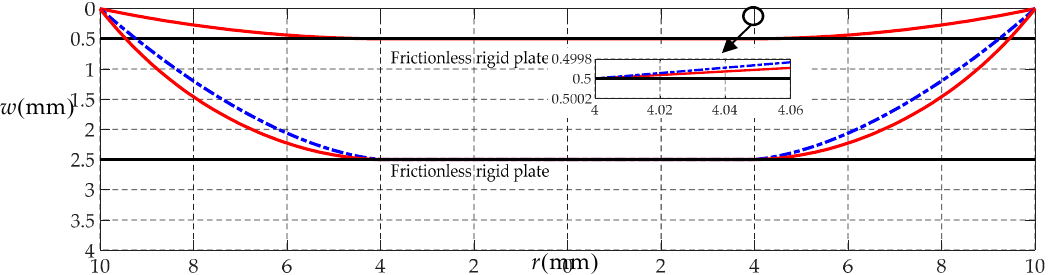
Figure 4. Variations of w with r for the gap g = 0.5 mm and the contact radius b = 4 mm corresponding to q = 0.001327 MPa and 0.001322 MPa calculated by the solutions presented in [28] (the dash-dotted lines) and presented here (the solid lines), and for g = 2.5 mm and b = 4 mm corresponding to q = 0.1654 MPa and 0.1576 MPa calculated by the solutions presented in [28] (the dash-dotted lines) and presented here (the solid lines).